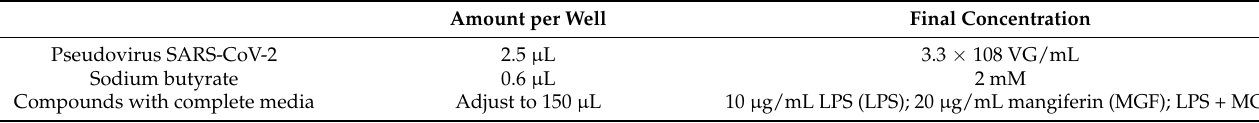
Table 2. Pseudo SARS-CoV-2 transduction mix. Amount per